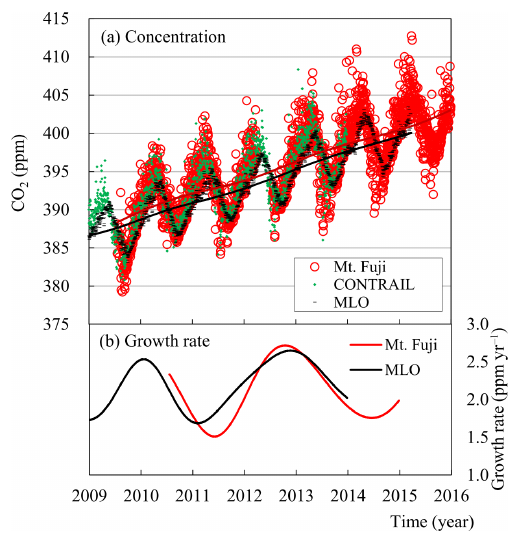
Figure 9. (a) Daily average of CO 2 concentration and the trend of CO 2 concentration (solid line), and (b) growth rates for data from Mt. Fuji, CONTRAIL, and Mauna Loa Observatory (MLO) 2009– 2015. Atmospheric CO 2 concentration at Mt. Fuji was measured at 22:00–23:28JST, compared with the daily average of atmospheric CO 2 concentration for CONTRAIL and MLO data. CONTRAIL data were selected over Japan in the region 34–36 ◦ N, 136–141 ◦ E at an altitude of 3600–3900m during 2009–2013, and Mauna Loa Observatory is located at a similar altitude (19.54 ◦ N, 155.58 ◦ W,